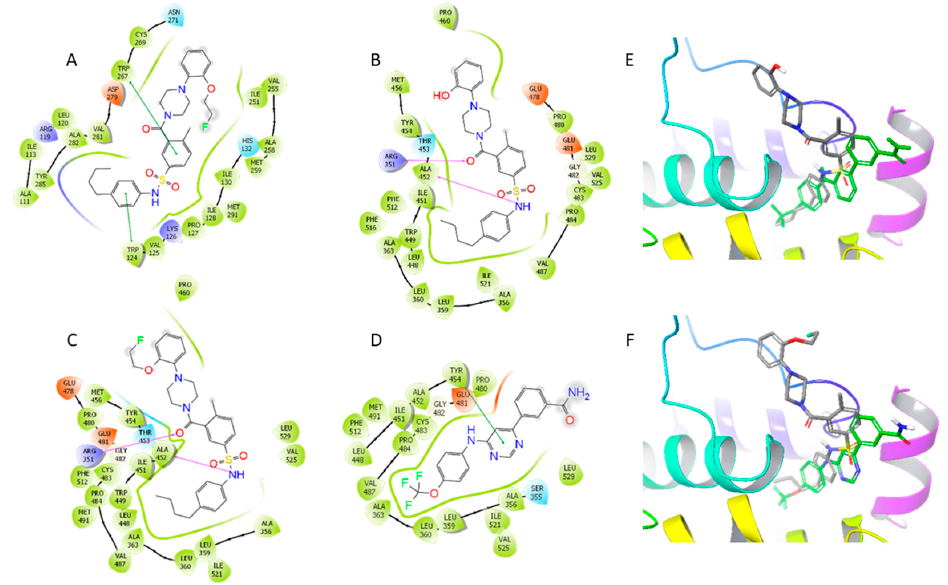
Figure 7. ( A ). TOS-2 docked to IDH1 R132H (PDB ID: 5DE1); ( B ). TOS-1 docked to the allosteric site of ABL1, PDB ID: 3K5V; ( C ). TOS-2 docked to the allosteric site of ABL1, PDB ID: 3K5V; ( D ). GNF-2 in its conformation from cocrystalling [35]; ( E ). and ( F ). TOS-1 and TOS-2, respectively, and GNF-2 in the overlay after docking to